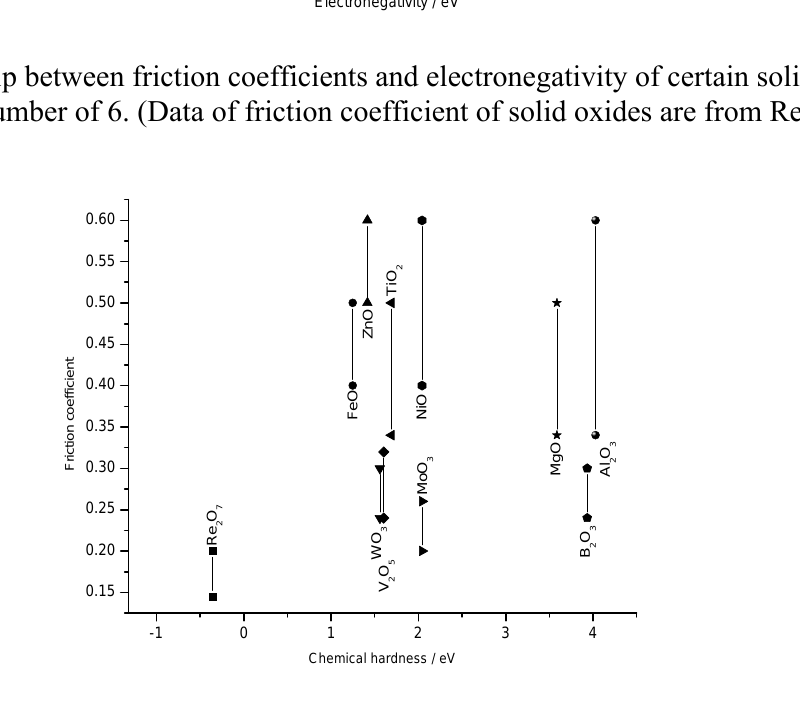
Figure 7. Relationship between friction coefficients and chemical hardness of certain solid oxides with coordination number of 6. (Data of friction coefficient of solid oxides are from Ref.